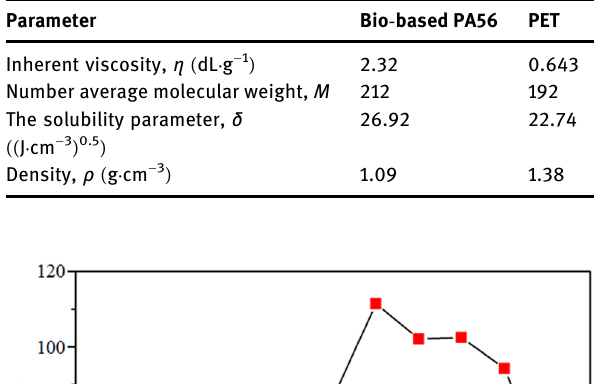
Table 4: Related parameters of bio - based PA56 and PET Parameter